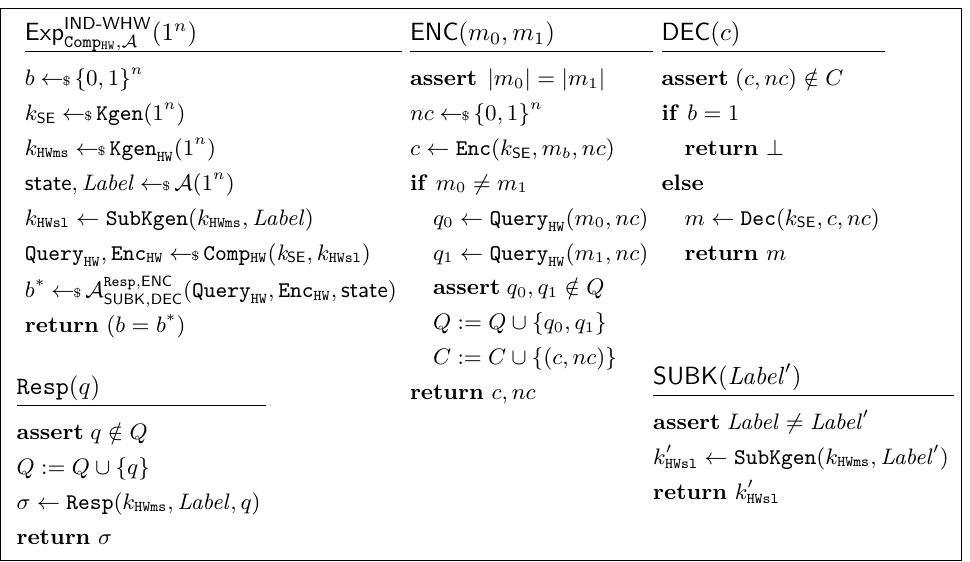
(1 n ) security Comp HW , A